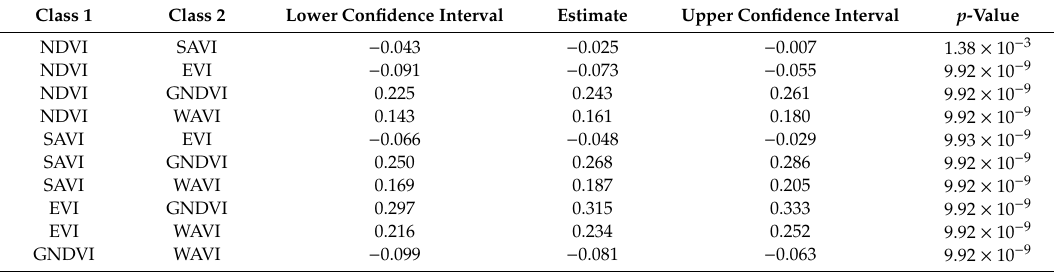
Table 4. Results of pairwise comparison among VI time series for S. alterniflora in the YRD based on Turkey HSD analysis.